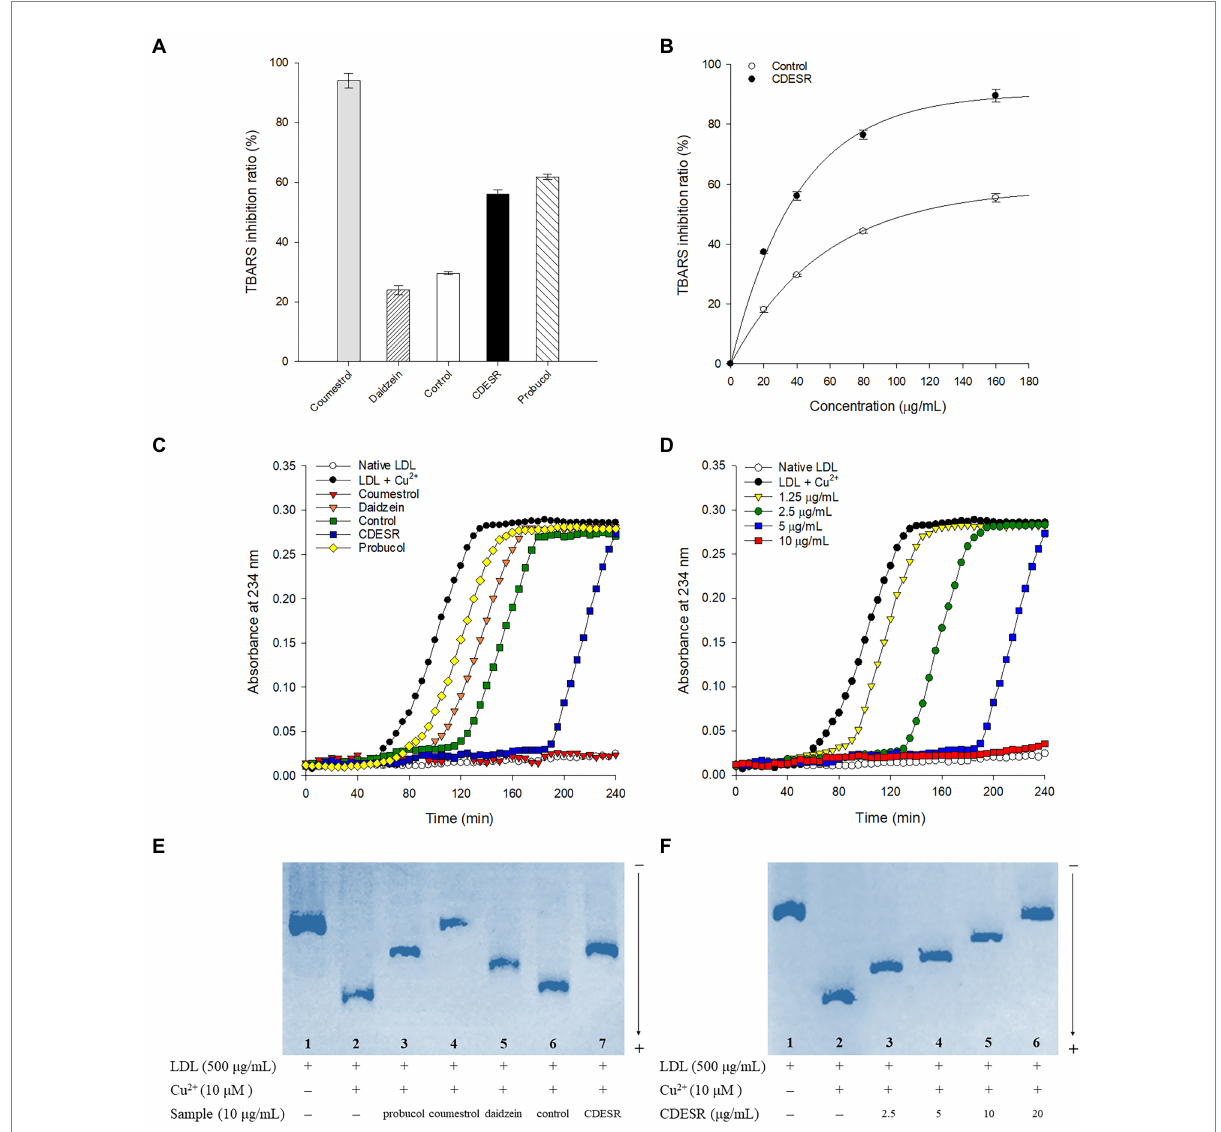
FIGURE 6 (A) Inhibitions of Cu 2+ -induced lipid peroxidation by 40 μ g/ml of coumestrol, daidzein, control soybean roots extract, and CDESR (coumestrol and daidzein enriched soybean roots) extract in the TBARS assay. Probucol was used as a positive control. Data represent the mean ± SE ( n = 3). (B) Dose-dependent effects of control roots and CDESR in the TBARS assay. Data represent the mean ± SE ( n = 3). (C) Inhibitory effects (extension of lag time) of 5 μ g/ml of samples on conjugated diene generation in Cu 2+ -induced LDL oxidation. (D) Dose-dependent effects of CDESR on conjugated diene generation. (E) Inhibitory effects on Cu 2+ mediated LDL oxidation by relative electrophoretic mobility (REM). Lane 1, native LDL (absence of Cu 2+ ); lane 2, oxidized LDL; lane 3–7, 10 μ g/ml of probucol, coumestrol, daidzein, control root extract, and CDESR extract. (F) Dose-dependent effects of CDESR by REM assay. Lane 1, native LDL; lane 2, oxidized LDL; lane 3–6, CDESR (2.5 μ g/ml– 0 μ